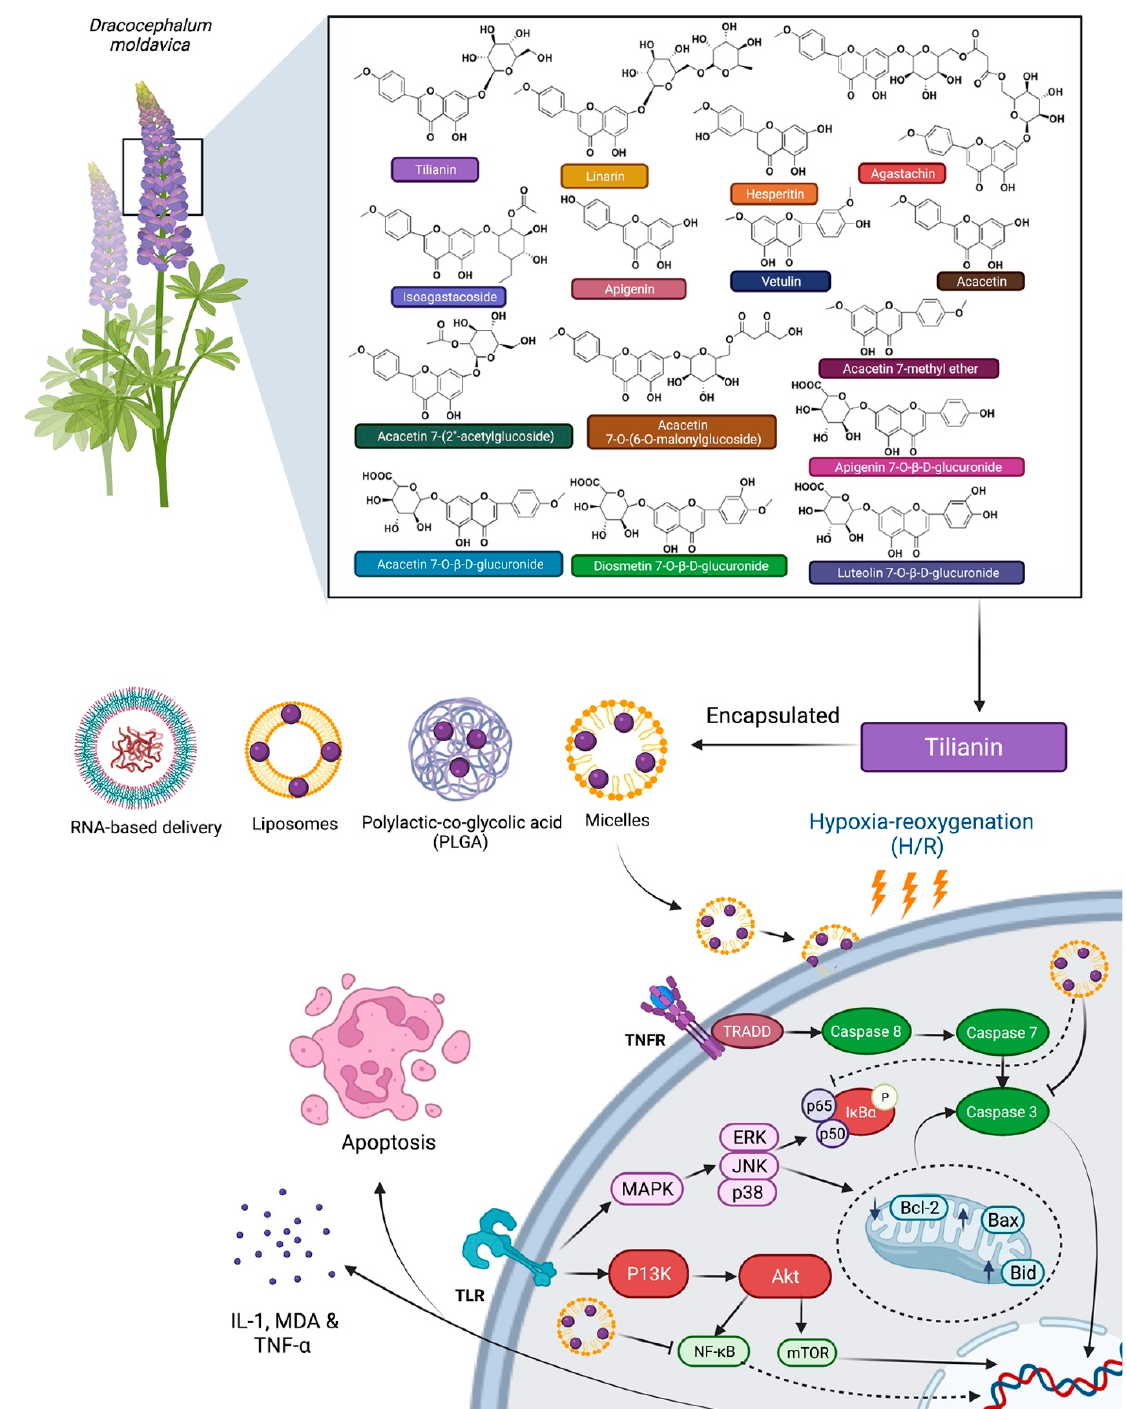
Figure 8. Chemical structure of tilianin derived/related compounds.